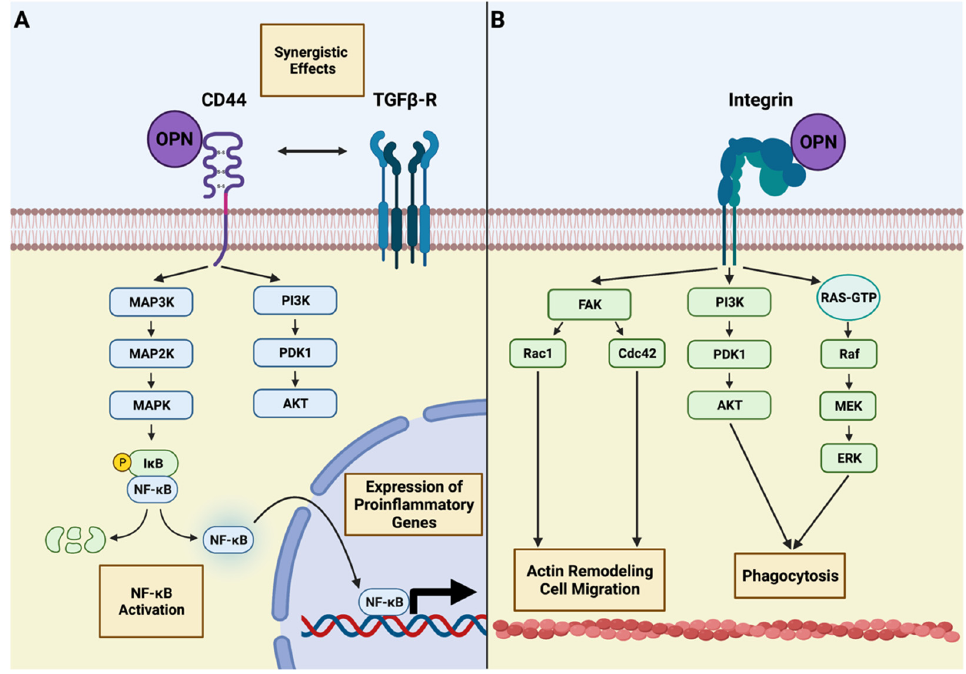
Figure 2. Osteopontin-related Pathways in Microglia. The interaction of OPN with CD44 leads to the engagement of several signaling pathways. ( A ) The activation of the phosphatidylinositol 3-kinase (PI3K)/AKT-pathway may be triggered by CD44 activation, followed by activation of the mitogen activated protein kinase (MAPK)-signaling pathway leading to the phosphorylation of the inhibitor of NF- κ B (I κ B) and the subsequent activation of the NF- κ B pathway, which causes the